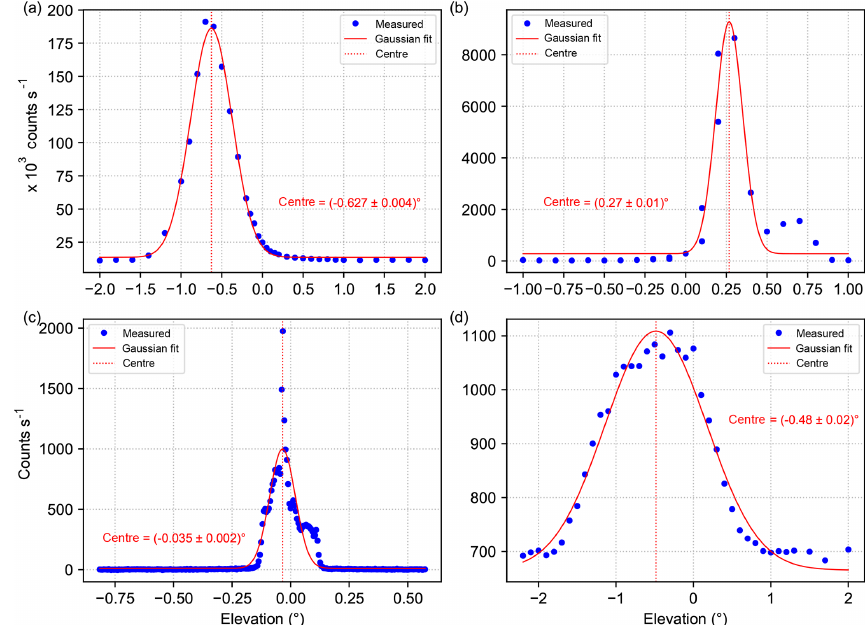
Figure 13. (a) Intensity curve at 436nm recorded on 19 September by the CMA_UV instrument. (b) Intensity curve at 546nm recorded on 19 September by the CMA_VIS instrument. (c) Intensity curve at 365nm recorded on 10 September by the BSU instrument. (d) Intensity curve at 365nm recorded on 8 September by the AIOFM instrument.